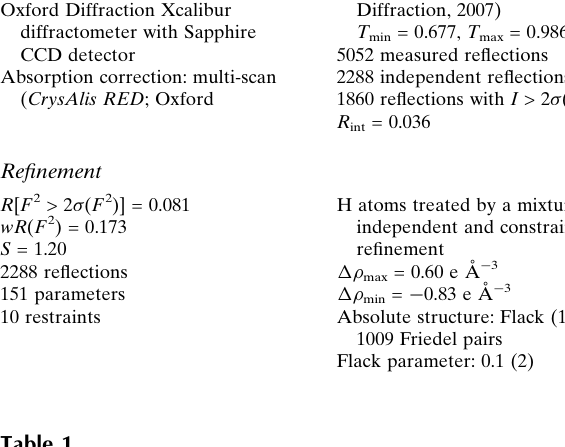
Hydrogen-bond geometry (A˚ , (cid:3)